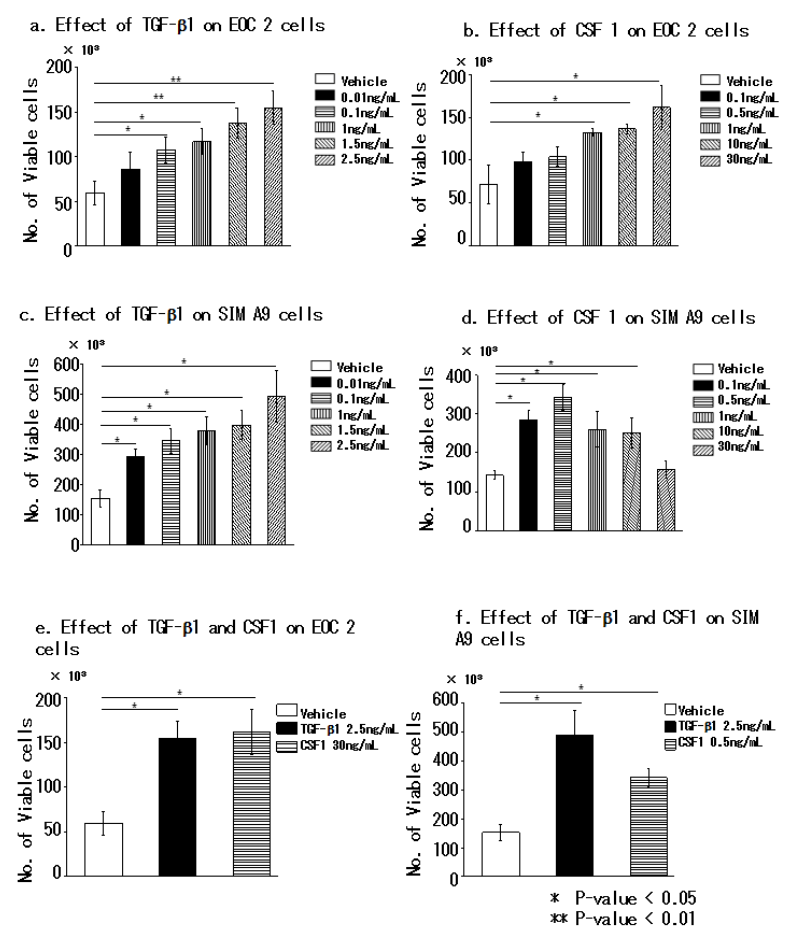
Figure 2. TGF- β and CSF 1 e ff ectively promote the proliferation of Figure 2. TGF-β and CSF 1 effectively promote the proliferation of microglia.